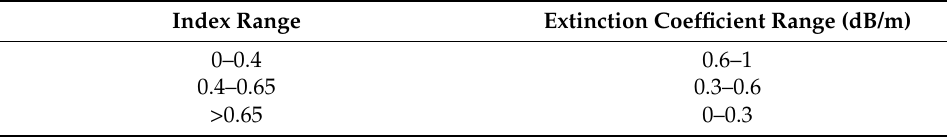
Table 1. The Limited Extinction Coefficient BASED ON the Geometrical